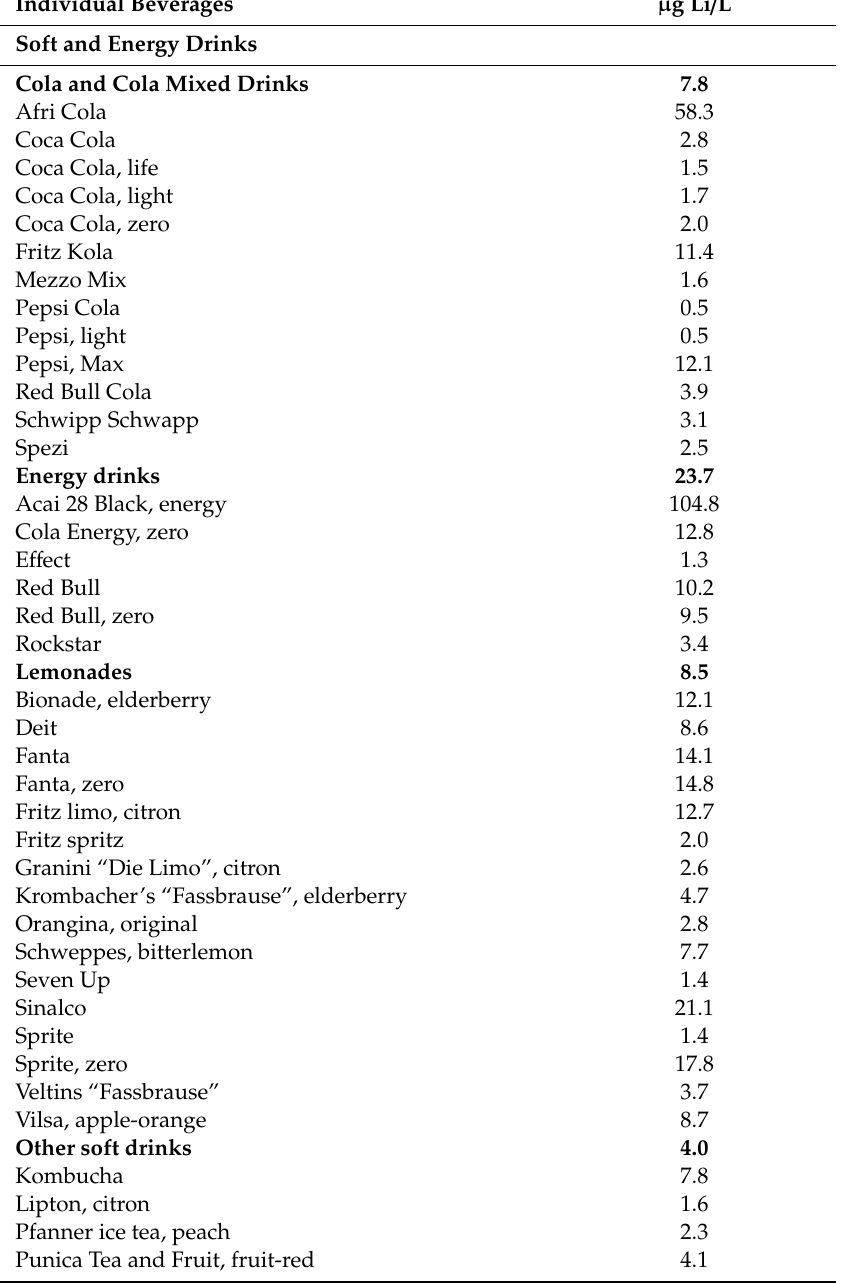
Table 5. Lithium concentrations ( µ g Li / L) of soft and energy drinks, grouped in cola and cola mixed drinks, energy drinks, lemonades and other soft drinks. Li concentrations were measured by inductively coupled plasma mass spectrometry